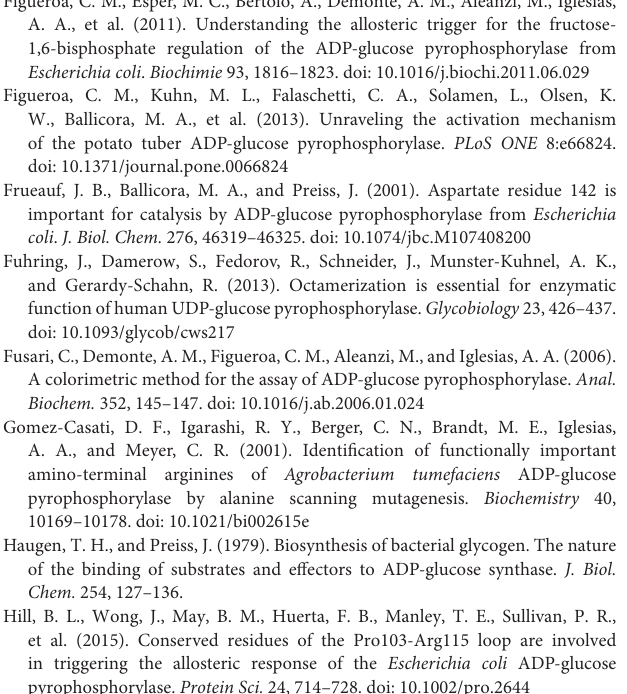
Figueroa, C. M., Esper, M. C., Bertolo, A., Demonte, A. M., Aleanzi, M., Iglesias, A. A., et al. (2011). Understanding the allosteric trigger for the